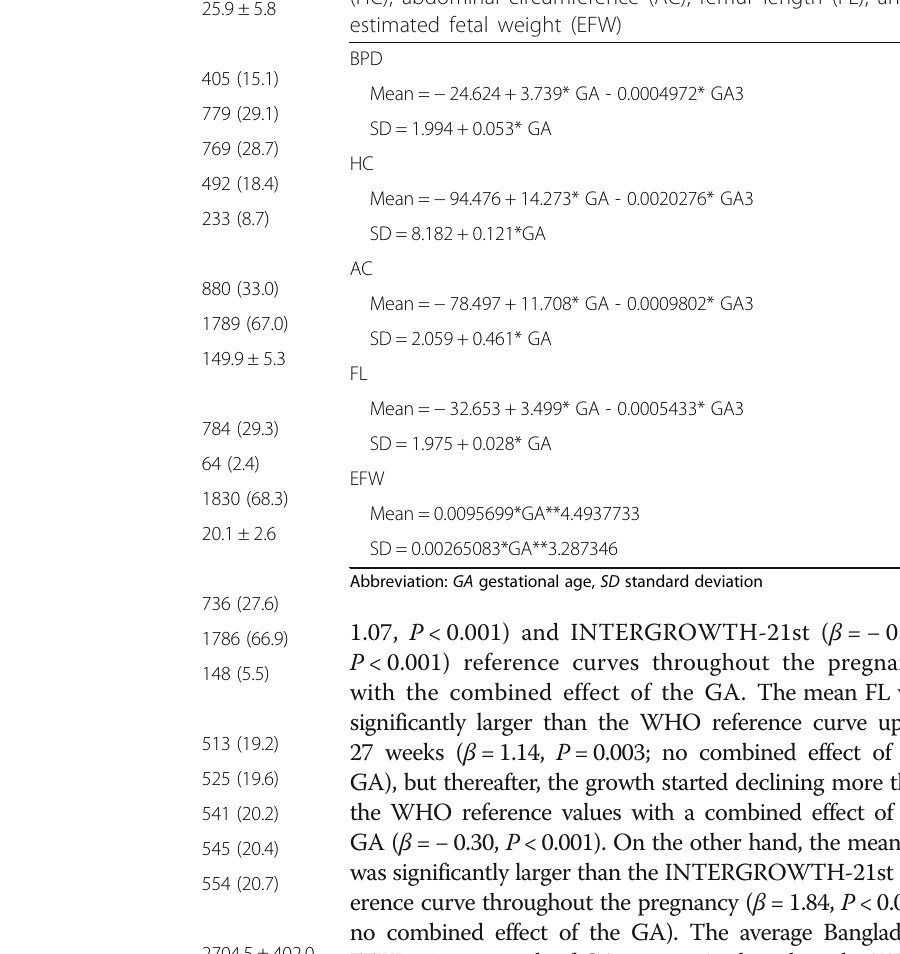
Table 2 Regression formula used to generate ultrasound biometry charts and tables of biparietal diameter (BPD), head circumference (HC), abdominal circumference (AC), femur length (FL),